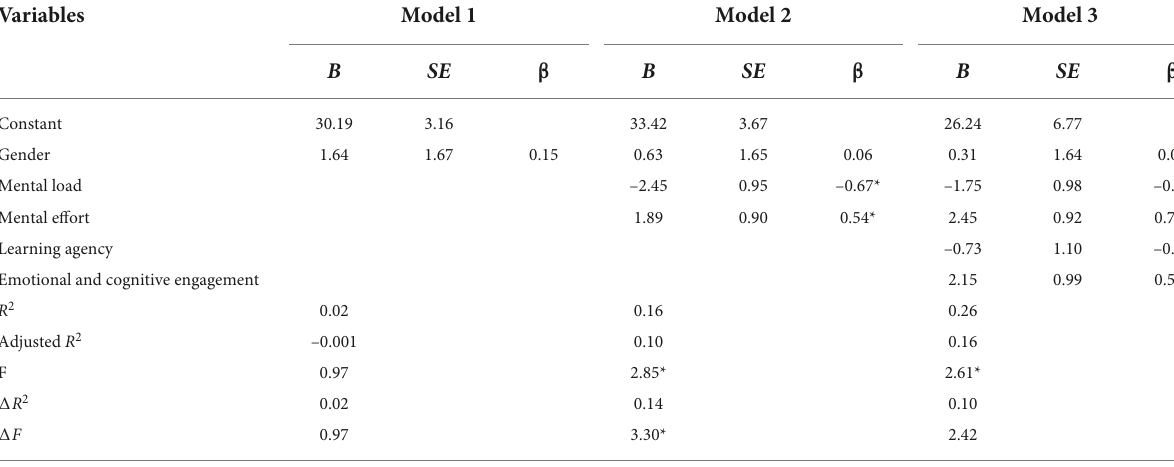
TABLE 2 Hierarchical regression analysis for FLC with the total score as the independent variable ( N = 44).